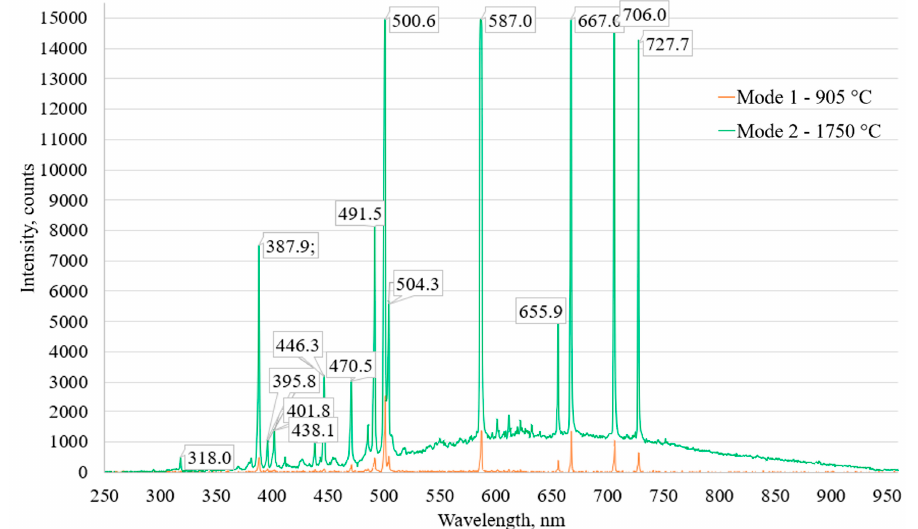
Figure 3. Graph of optical spectra under two temperature modes (905 °C and 1750 °C) of tungsten samples irradiation with helium plasma.